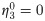
Three types of solutions for the coupled nonlocal Klein-Gordon eq (3). (a)Periodic line waves solution with parameters N = 1, P1 = 2, η30=0, ϵ = 1. (b)Breather solution given by (29) with parameters (31). (c)A mixed solution consisting of a breather and periodic line waves with parameter (33) and p1=12,p2=−12,η10=0,η20=0.